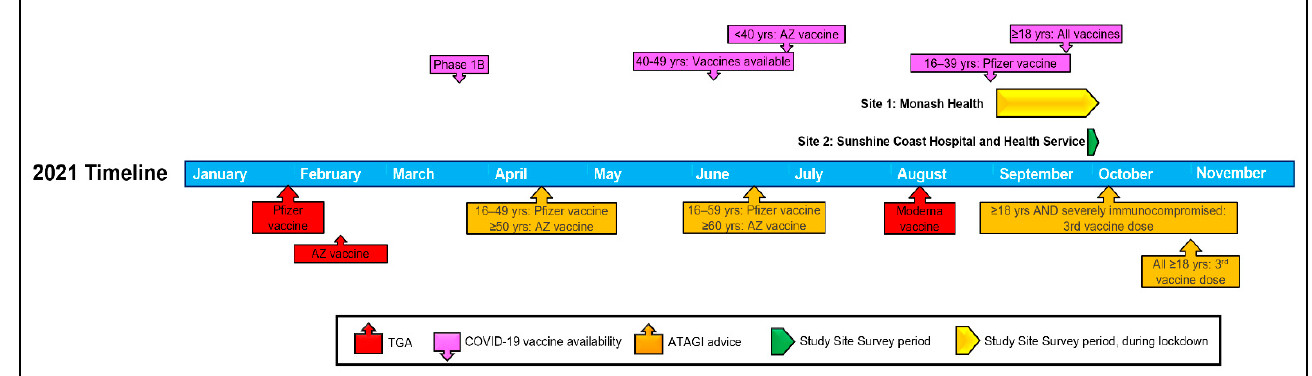
Figure 1. Timeline of the survey period with notable Australian COVID-19 vaccine roll-out events in 2021. People with MS could access COVID-19 vaccination from the commencement of Phase 1B during the COVID-19 vaccine rollout in March 2021. The survey period at Monash Health was undertaken during a strict state-wide government lockdown. Abbreviations: ATAGI, Australian Technical Advisory Group on Immunisation; Years, Yrs; AZ, Astra-Zeneca; TGA, Therapeutic Goods Administration—COVID-19 Vaccine Provisional Registration.